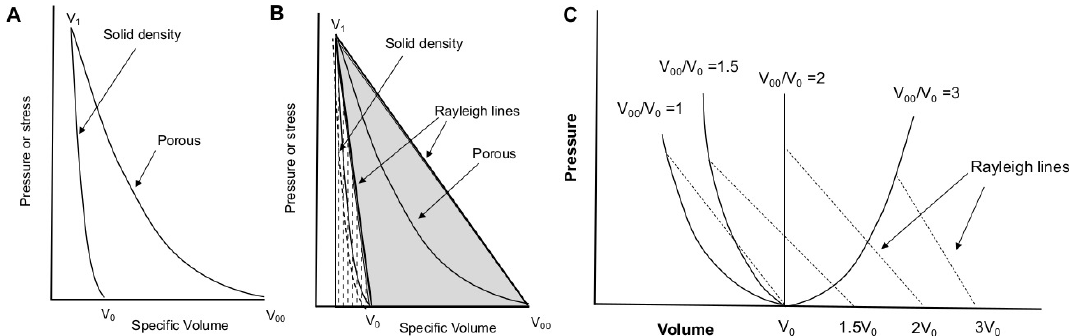
Figure 3. ( A ) Hugoniots for solid-density and porous material in the normal (non-anomalous) regime. The foam is compressed from initial specific volume V 00 to solid volume V 1 , undergoing far greater compression than the solid material shocked from V 0 to the same final volume. ( B ) The internal energy rise upon shock loading is given by the area under the Rayleigh line, indicated by the solid gray and dotted areas for porous and solid material, respectively. The internal energy (and thus, temperature) rise is much greater in the porous case than in the solid. ( C ) As in ( A , B ), but showing the effect of anomalous compression, in which the porous material Hugoniot does not approach that of the solid due to shock